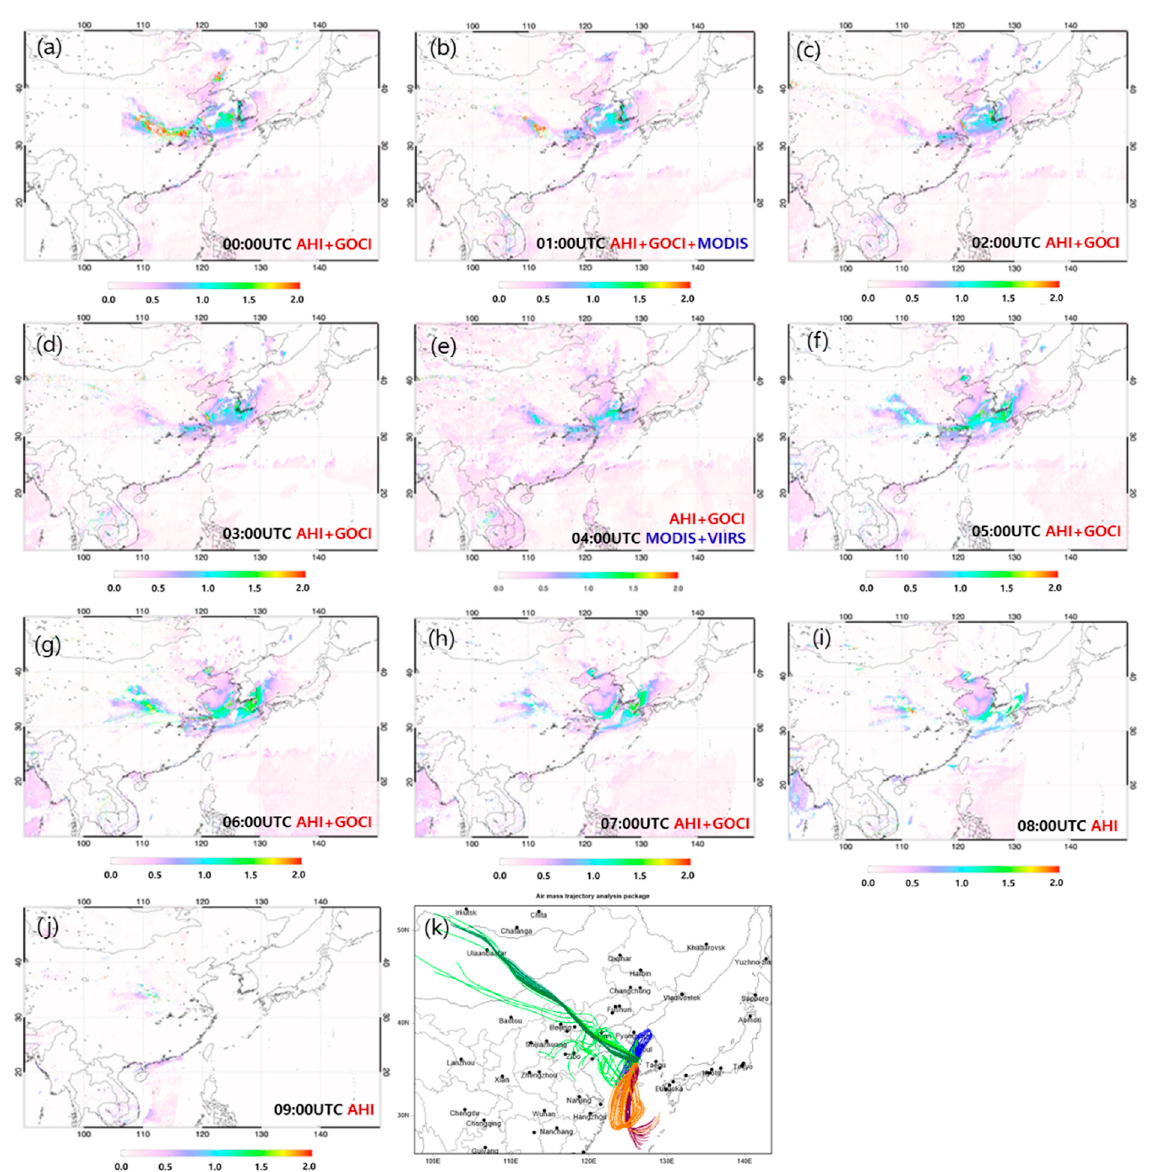
Figure 6. Hourly composites of AOD from 00:00–09:00 UTC on 18 April 2017, and a three day back trajectory of the HYSPLIT Model: ( a ) 00:00 UTC, ( b ) 01:00 UTC, ( c ) 02:00 UTC, ( d ) 03:00 UTC, ( e ) 04:00 UTC, ( f ) 05:00 UTC, ( g ) 06:00 UTC, ( h ) 07:00 UTC, ( i ) 08:00 UTC, ( j ) 09:00 UTC, and ( k ) HYSPLIT on 15 (orange), 16 (purple), 17 (blue), 18 (light green), and 19 (green), April.